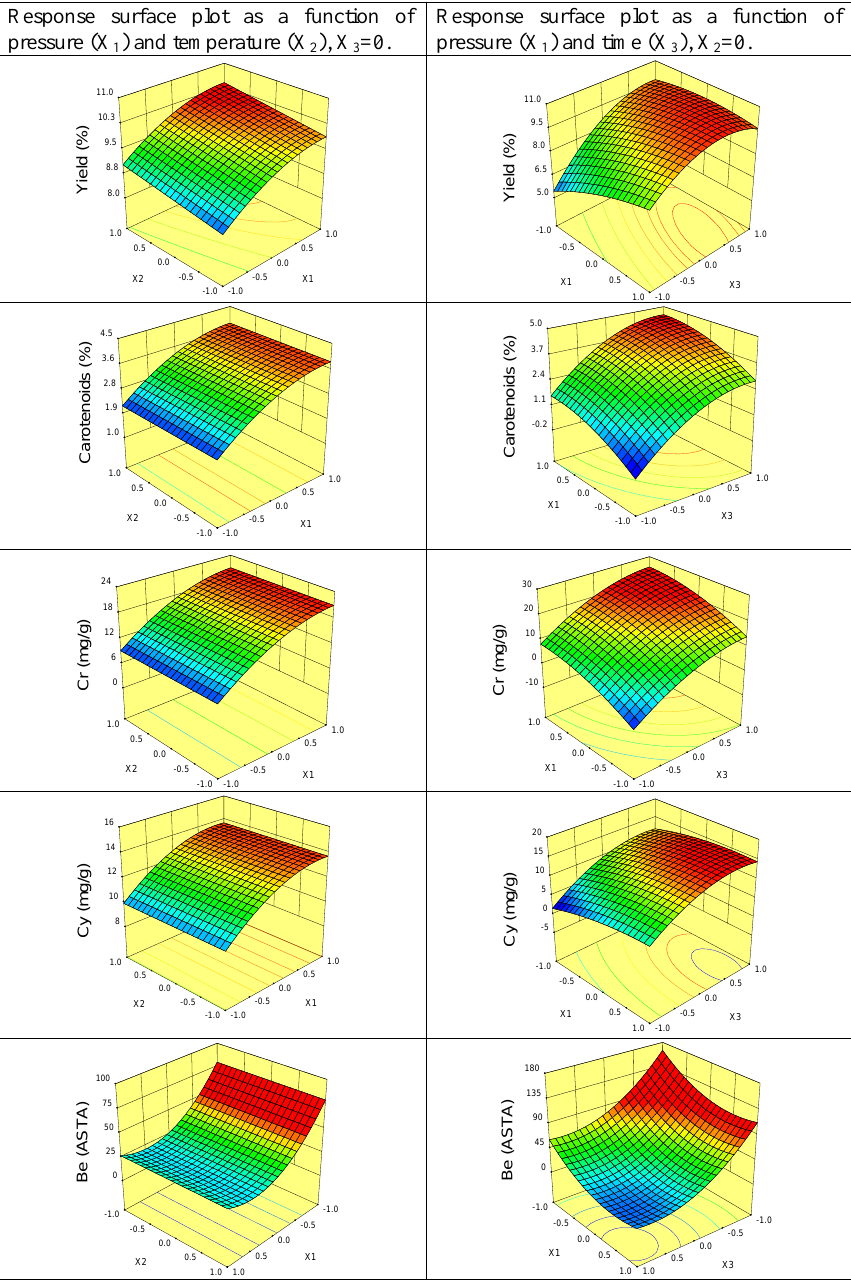
Figure 3. Diagrams of the response surface for response variables Y e , C k , C r , C y , and B p in the function of extraction parameters. B e : color value of extract; C r : concentration of red carotenoid fraction in extract; C y : concentration of yellow carotenoid fraction in the extract. The obtained results show that extraction pressure and time are important parameters influencing the total content of carotenoids in extract, the concentration of yellow and red carotenoids in the extract, and the color value of extract. The increased value of response variables C k , C r , C y , and B e with the increase in pressure and time was, on the one hand, the result of an increase in the solubility of carotenoids in carbon dioxide related to the increasing solvent density and, on the other hand, a longer contact time between solute and solvent. As for extraction yield, an increase in extraction time from 10